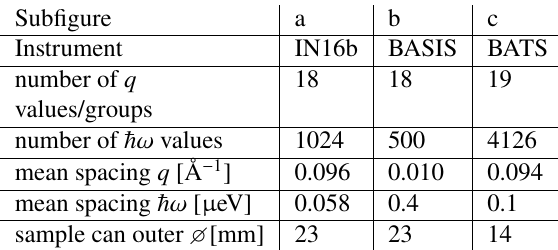
Table 1: Specifications of the spectra shown in Fig.